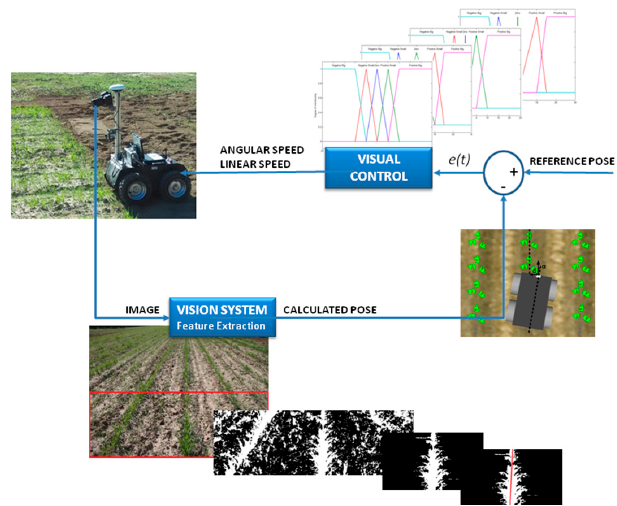
Figure 9. Visual scheme of the developed control.